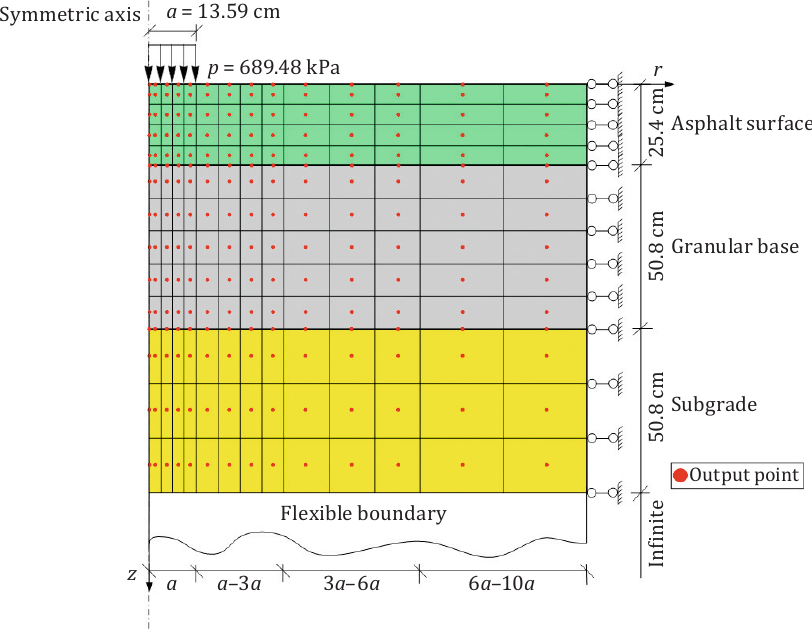
Figure 8. The schematic diagram of the model used for the analysis